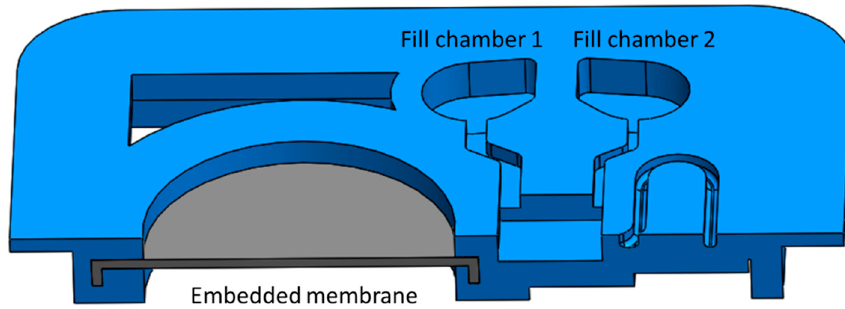
Figure 2. Embedded rubber-like membrane. Embedding the elastic membrane is necessary to avoid delamination.